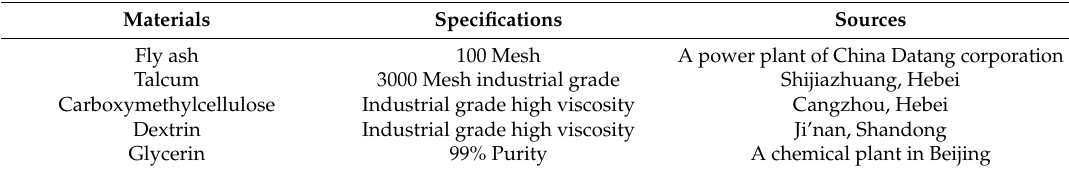
Table 2. Raw materials of ceramic membrane